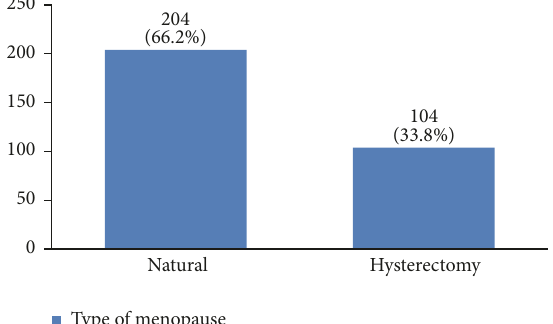
Figure 15: The menopause type of the studied breast cancer cases.